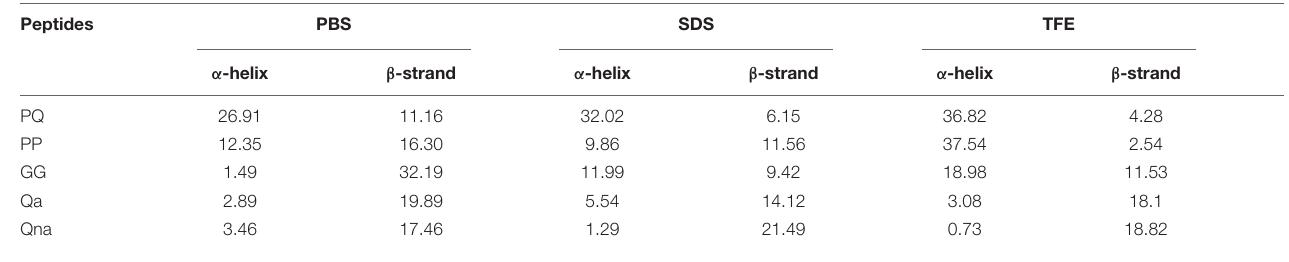
TABLE 2 | Percentage of different secondary structure of the peptides in various solutions. Peptides PBS SDS TFE α -helix β